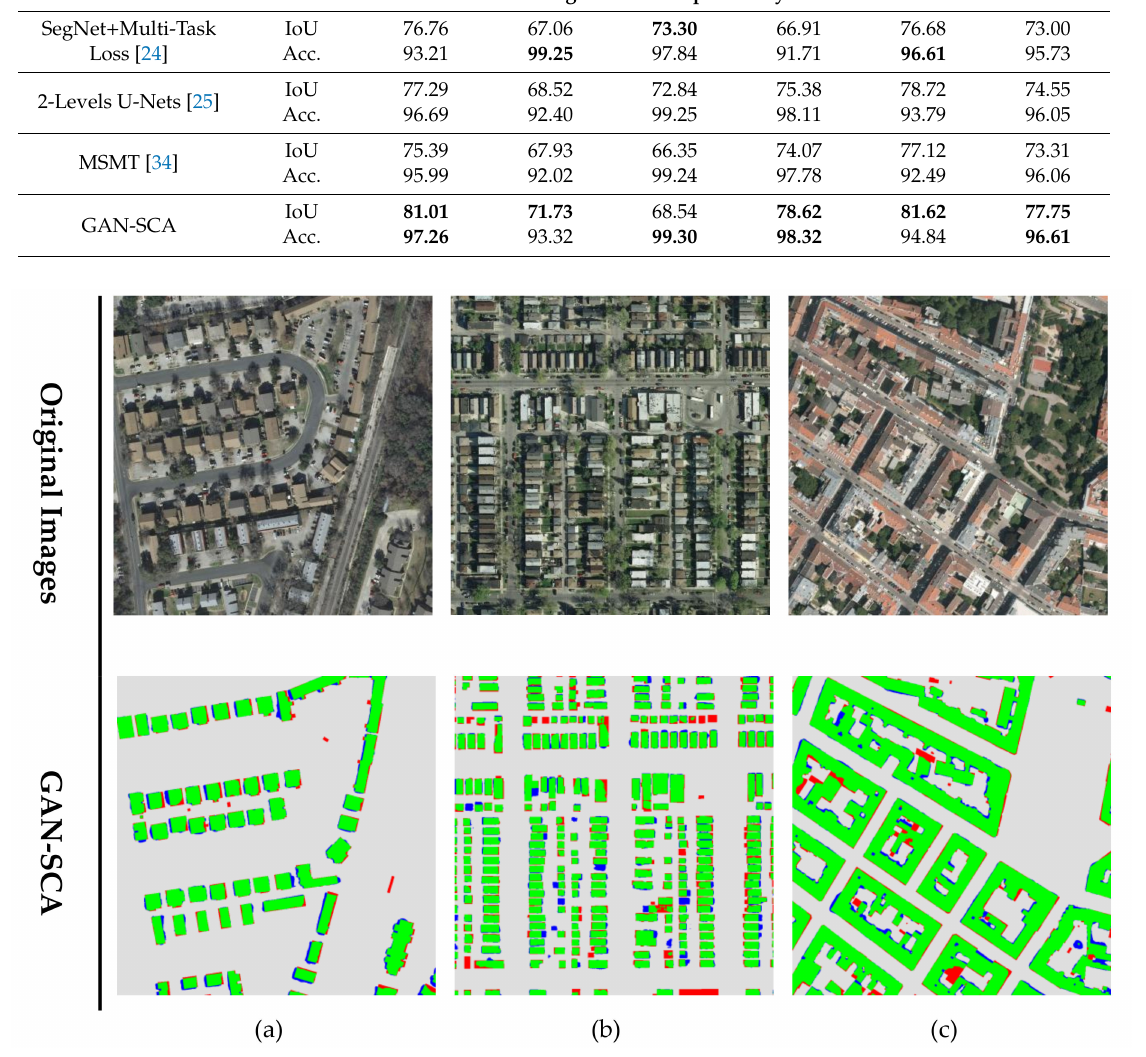
Figure 6. Building extraction results of Inria aerial image labeling dataset. ( a ) Image patch over Austin; ( b ) Image patch over Chicago; ( c ) Image patch over Vienna. Green: true positive (tp) pixels; Gray: true negative (tn) pixels; Blue: false positive (fp) pixels; Red: false negative (fn)